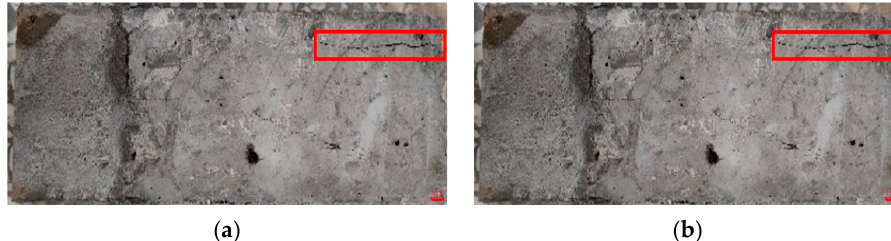
Figure 12. Partial cracking damage status of the OC/ECC slant shear test specimens. ( a ) OC/ECC-N; ( b ) OC/ECC-Y.